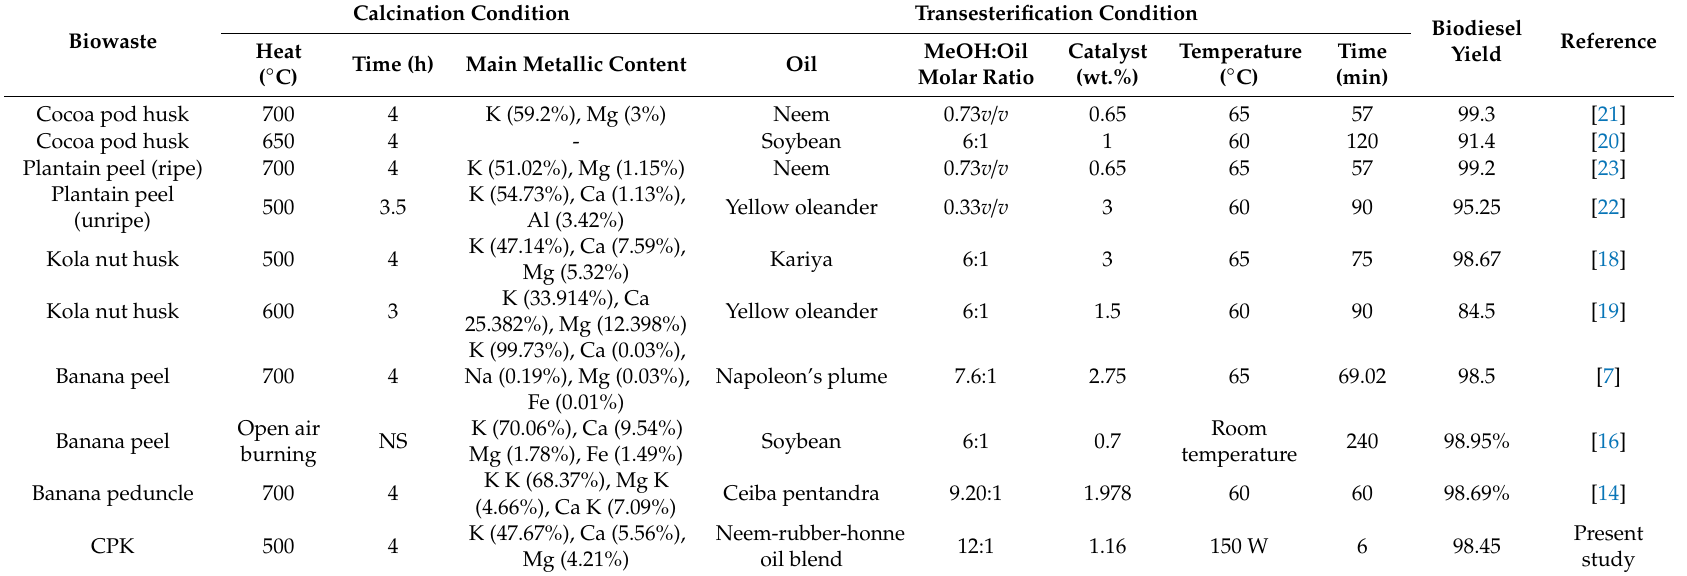
Table 1. Solid based-heterogeneous catalyst derived from